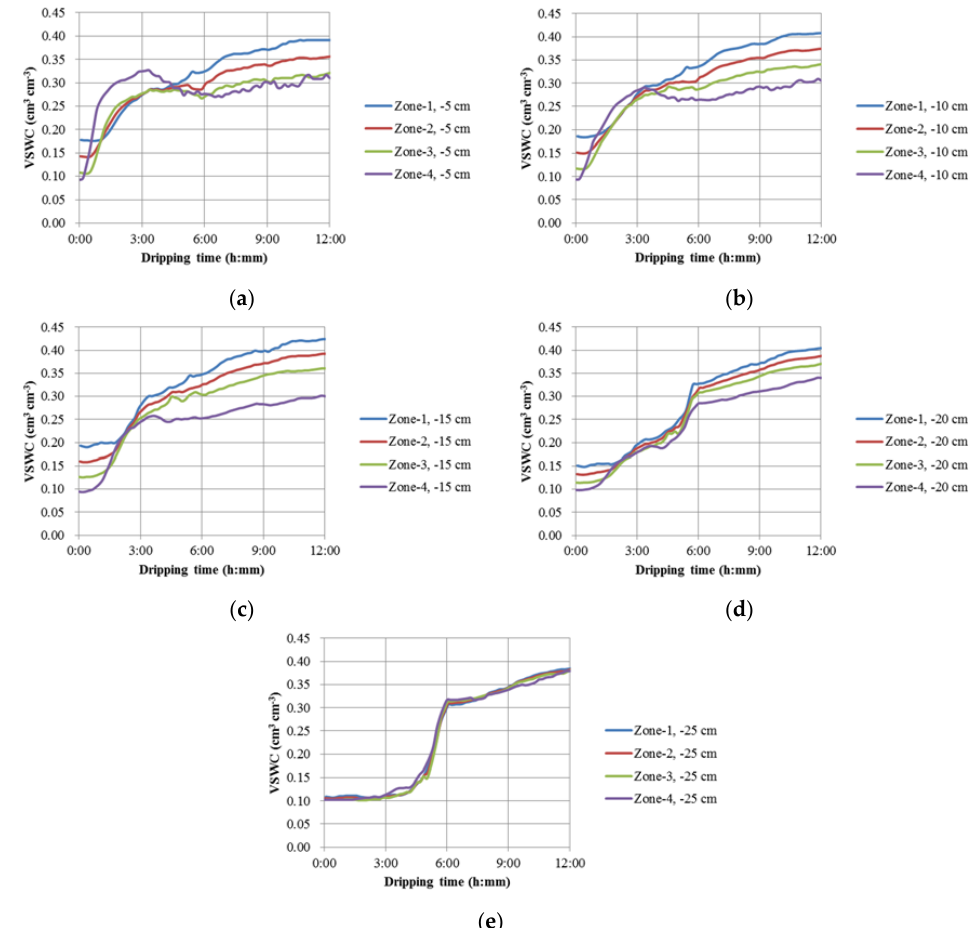
Figure 7. Temporal variations of the soil water content along the horizontal direction (X- and Y-Axis) at the depths of ( a ) 5 cm ( − 5 cm), ( b ) 10 cm ( − 10 cm), ( c ) 15 cm ( − 15 cm), ( d ) 20 cm ( − 20 cm) and ( e ) 25 cm ( − 25 cm) under single ‐ drip irrigation conditions.